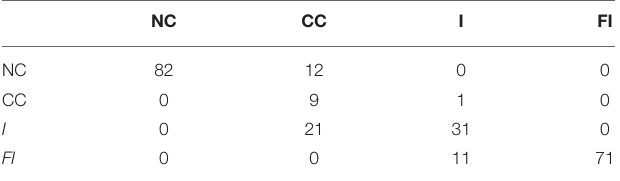
TABLE 3 | Confusion matrix of model 1 validated using observation of Peg 2 .